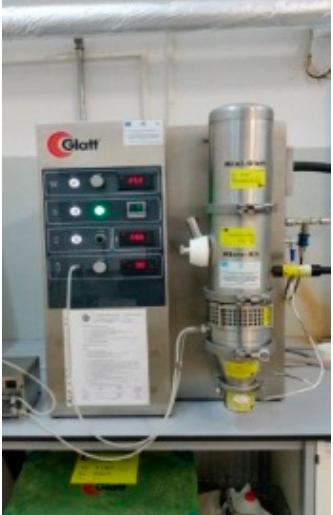
Figure 2. Fluidized bed granulator.